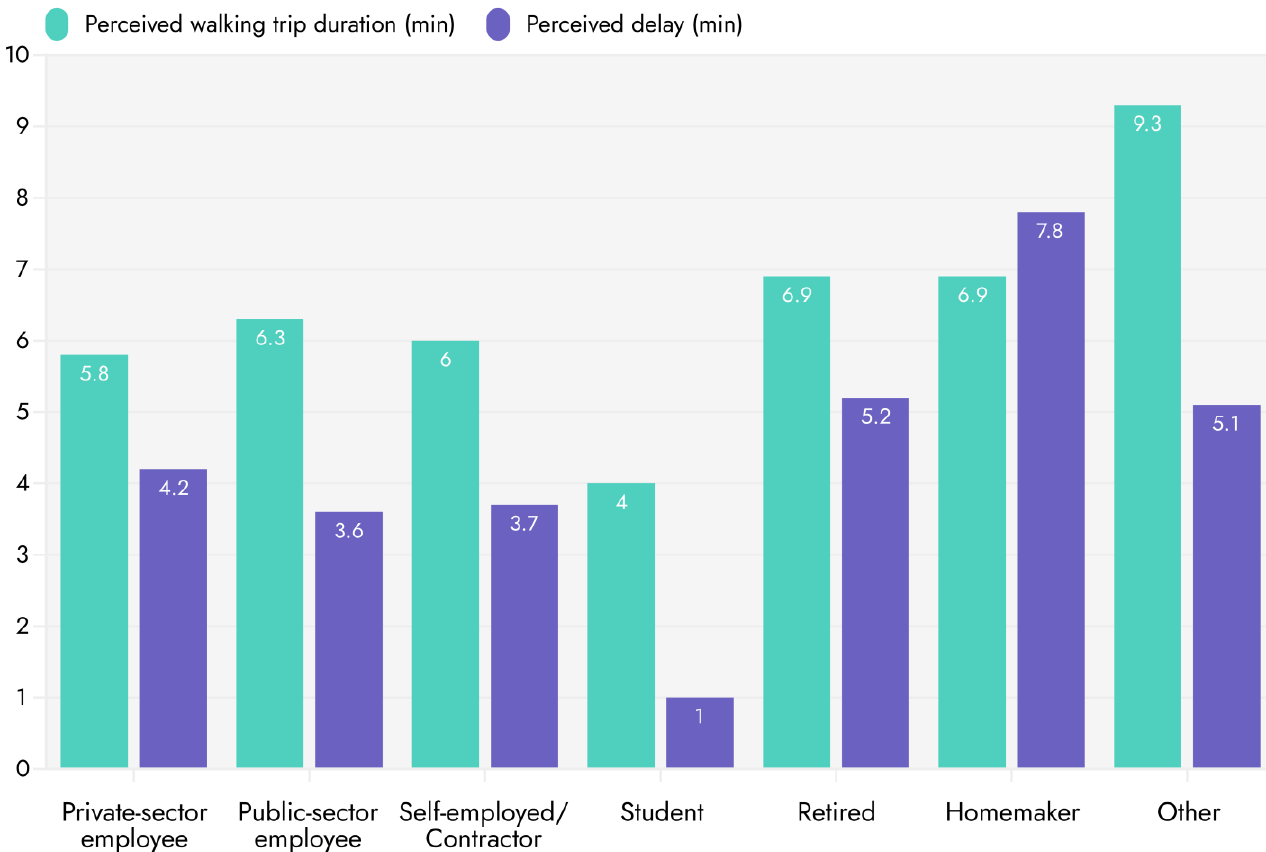
Figure 9. Bar chart illustrating the mean values of the perceived walking trip duration and the perceived delay for the different types of employment status.